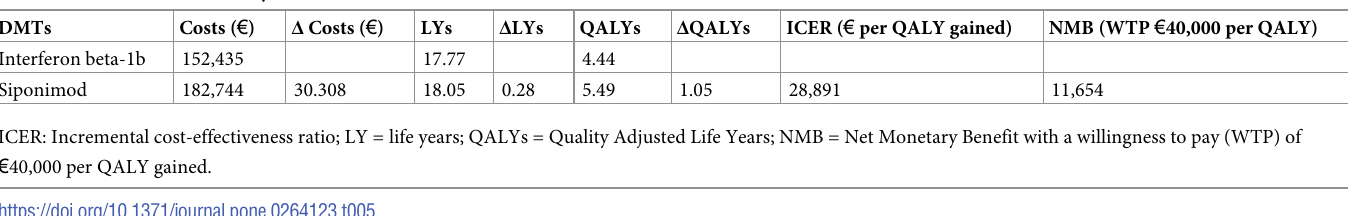
Table 5. Cost-effectiveness analysis results.